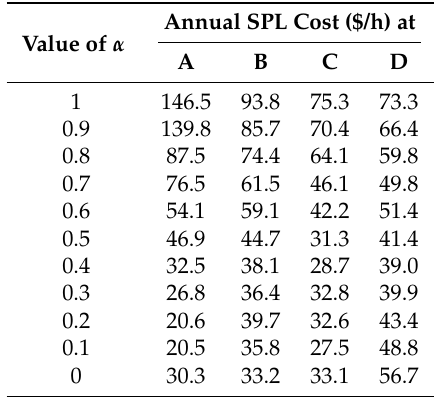
Table 3. Influence of RES mix on the average annual SPL cost ($/h).